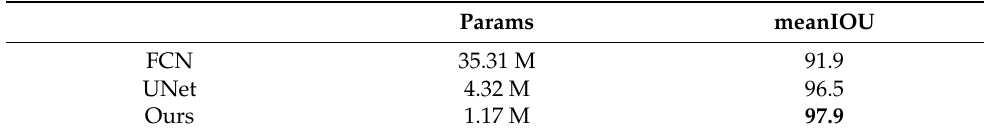
Table 4. Road segmentation models evaluated on the UAS test set.